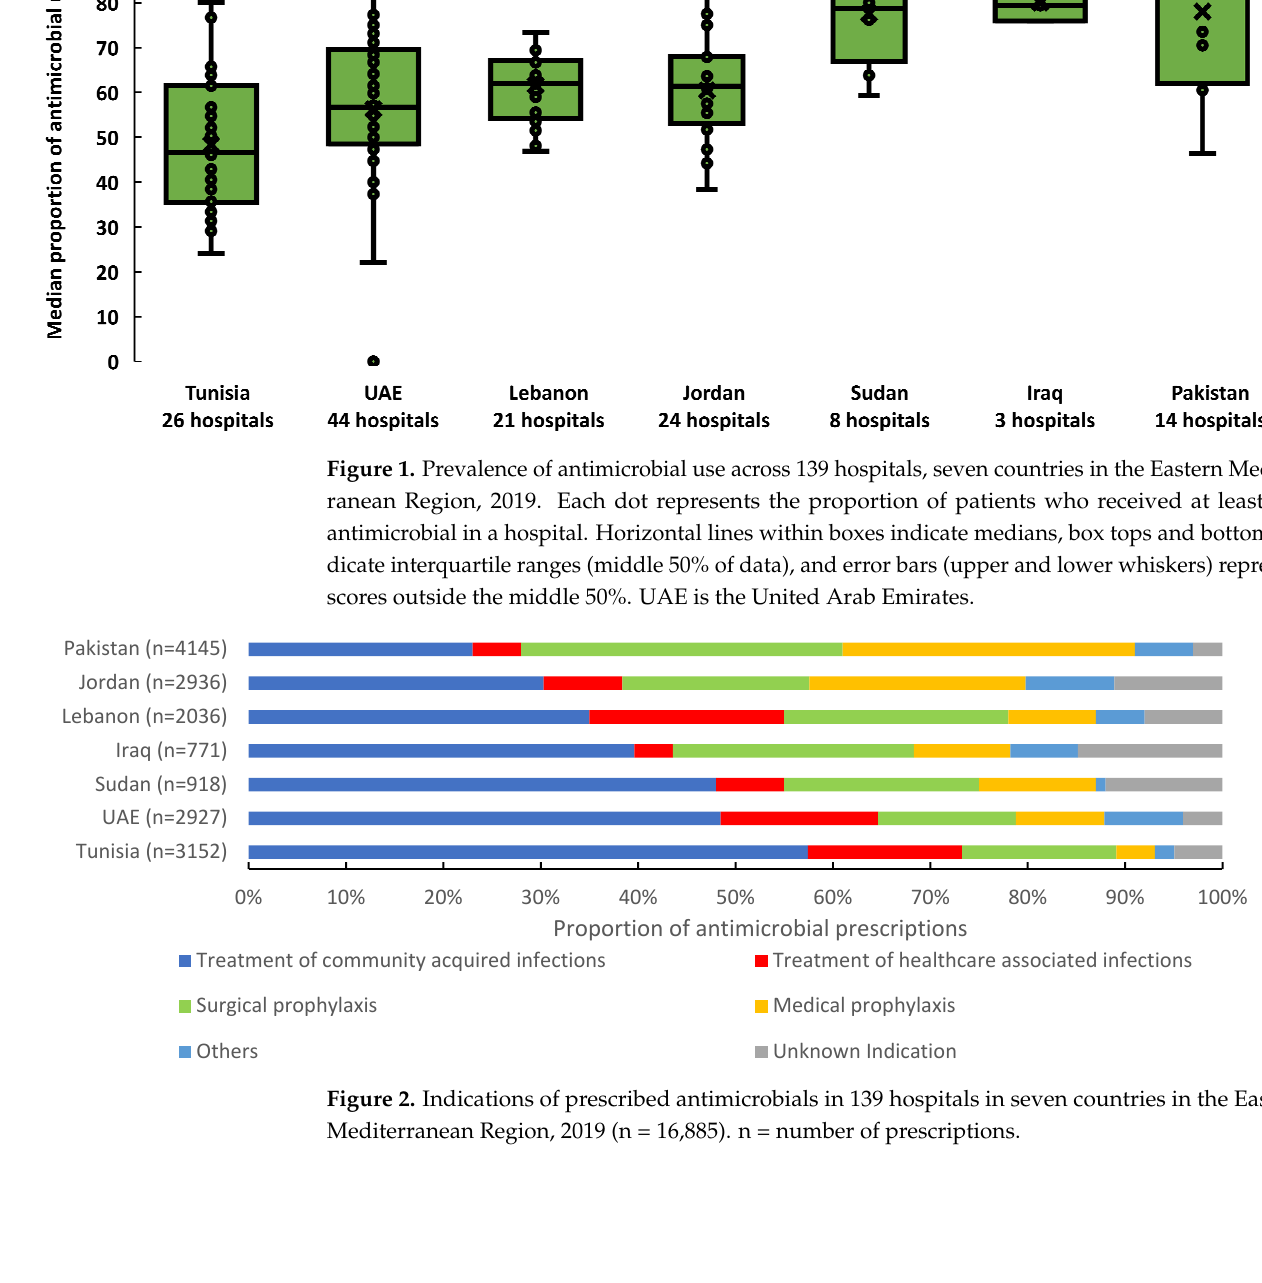
Figure 3. Distribution of prescribed antimicrobials according to clinical indications, seven countries in Eastern Mediterranean Region *, 2019. * Seven countries are Tunisia, United Arab Emirates, Leb- anon, Jordan, Pakistan, Sudan, and Iraq. $ Other antimicrobials include systemic antivirals, antipro- tozoals, intestinal anti-infectives, antimycotics. for systemic use and antimycobacterial. (n = number of prescriptions). 2.3. Types of Prescribed Antimicrobial Groups Of 16,885 antimicrobial prescriptions, antibacterials accounted for 95.2% (16,071) while antimycobacterial, antimycotics for systemic use, antiprotozoals and systemic anti- virals represented only 4.8%. Table 1 presents the ten most common antimicrobial groups prescribed, with a total number of 15,391 prescriptions. The top four prescribed antimi- crobial groups were third-generation cephalosporins (n = 4516, 26.7%), beta-lactam peni- cillins (n = 3056, 18.1%), imidazole derivatives (n = 1655, 9.8%) and carbapenems (n = 1385, 8.2%). Third-generation cephalosporins were the most prescribed antimicrobials in Iraq (38.4%), Pakistan (38.5%), Sudan (31.7%), and Jordan (28.6%). First- and second-